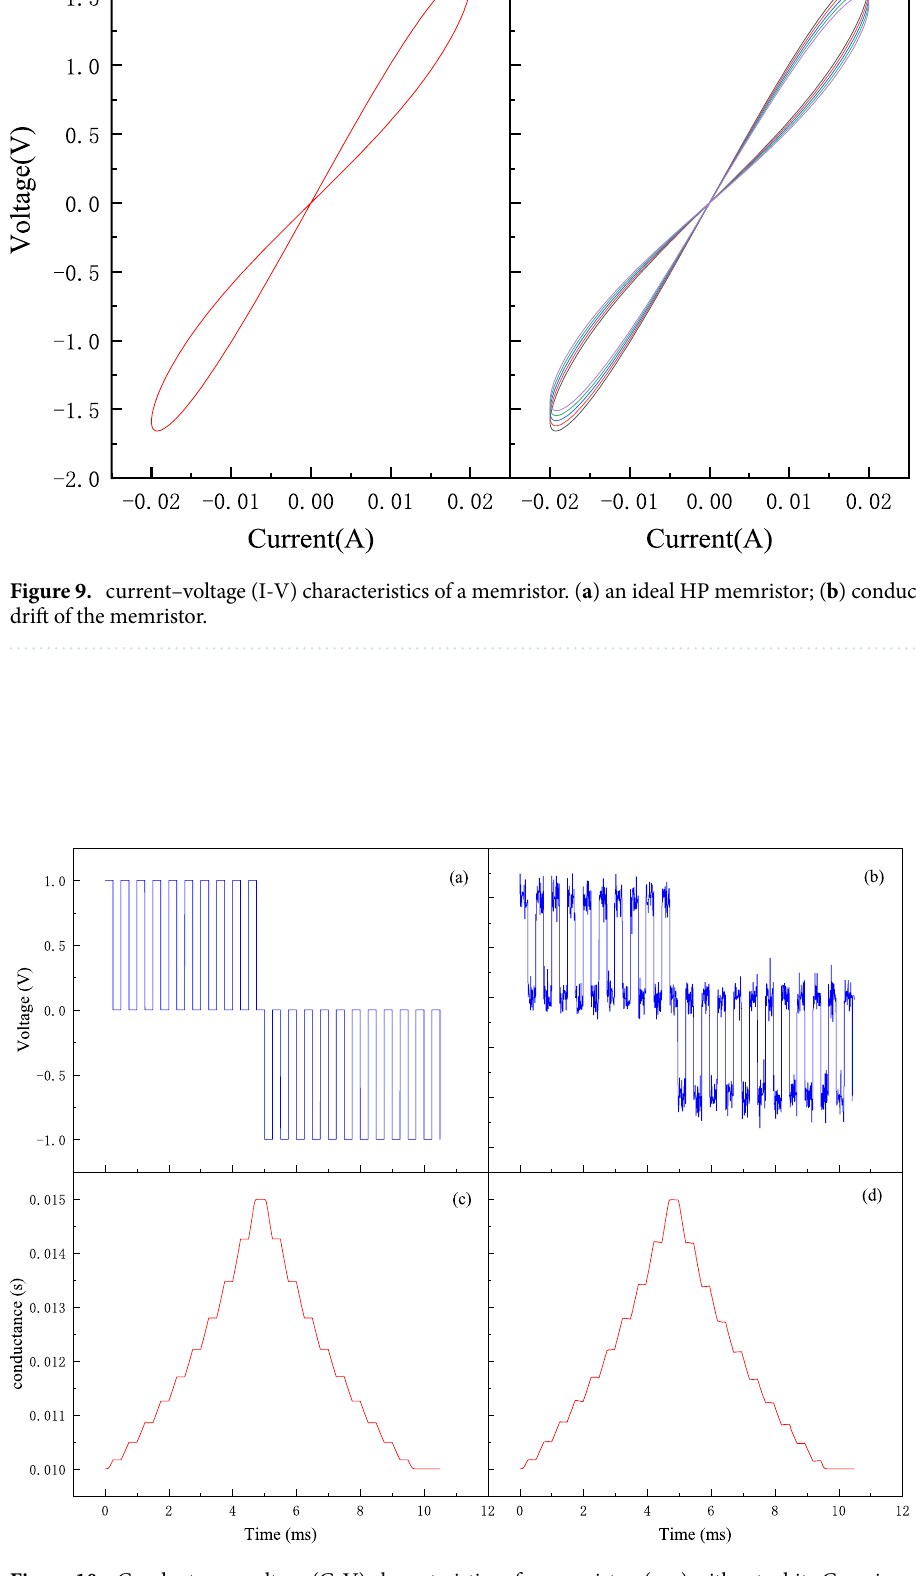
Figure 10. Conductance-voltage (G-V) characteristics of a memristor. ( a , c ) without white Gaussian noise; ( b , d ) with white Gaussian